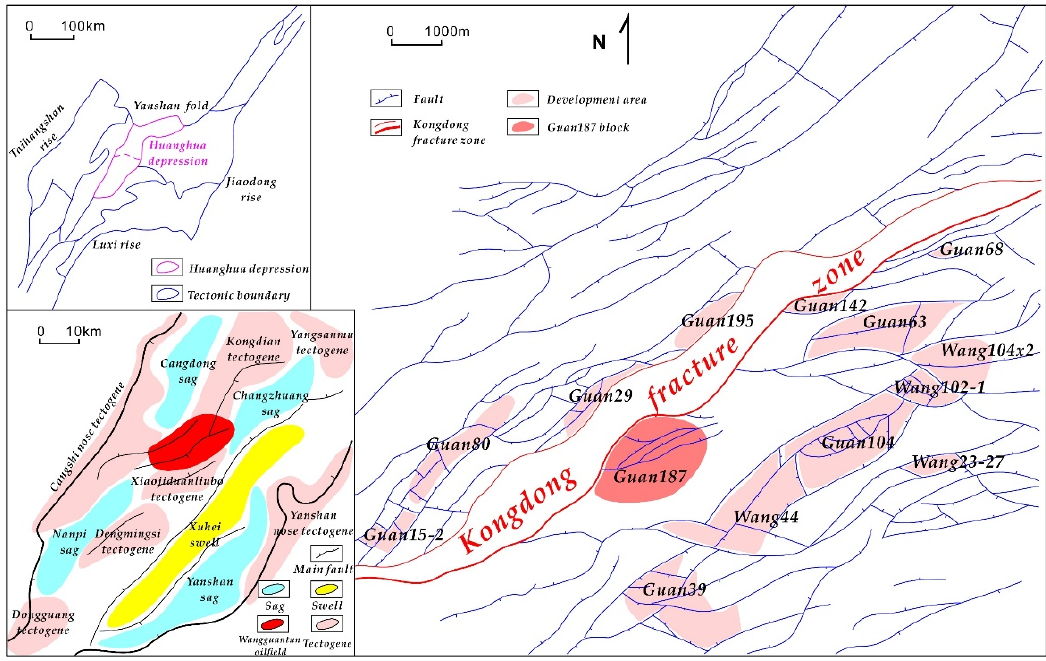
Energies 2023 , 16 , x FOR PEER REVIEW